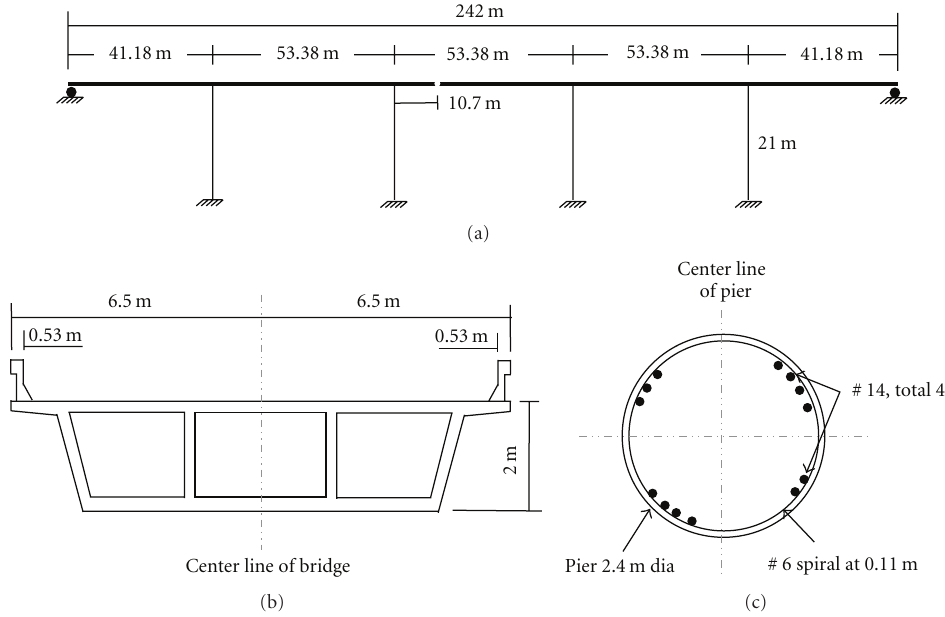
Figure 4: (a) Bridge model under consideration, (b) cross-section of the bridge girder, and (c) cross-section of pier (not to